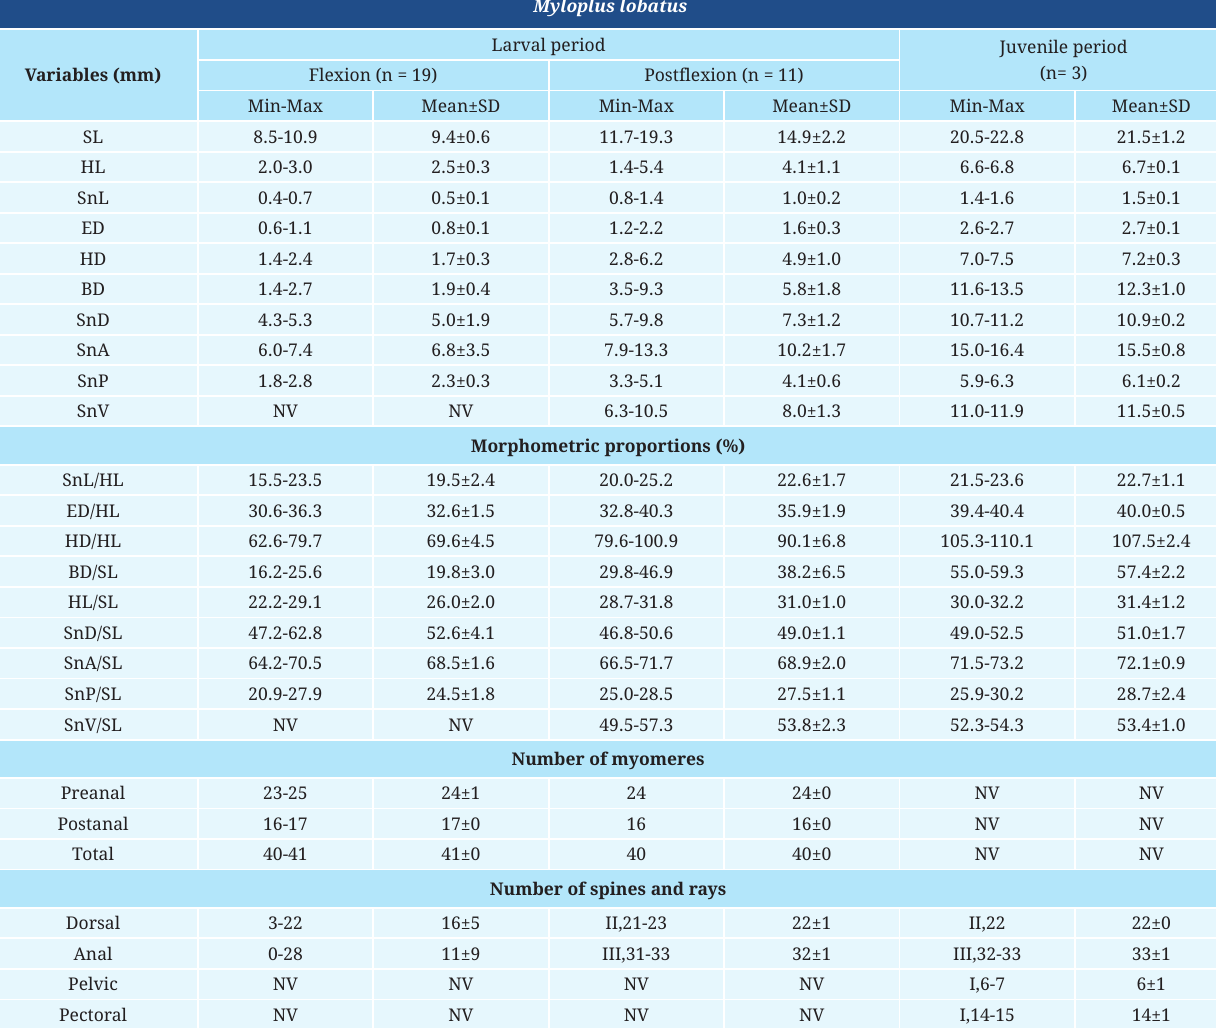
TABLE 3 | Values of minimum (Min), maximum (Max) and mean length (mm) and standard deviation (SD) of morphometric and meristic variables obtained from larvae and juveniles of Myloplus lobatus . SL: standard length; HL: head length; SnL: snout length; ED: eye diameter; HD: head depth; BD: body depth; SnD: snout-dorsal fin distance; SnA: snout-anal fin distance; SnP: snout-pectoral fin distance; SnV: snout- pelvic fin distance; NV: not